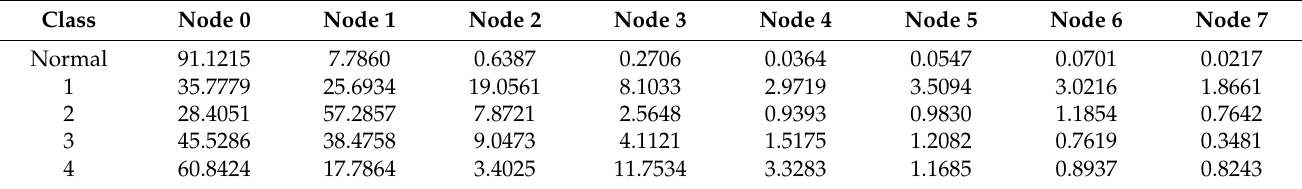
Table 4. Frequency domain features of vibration signal in x -axis